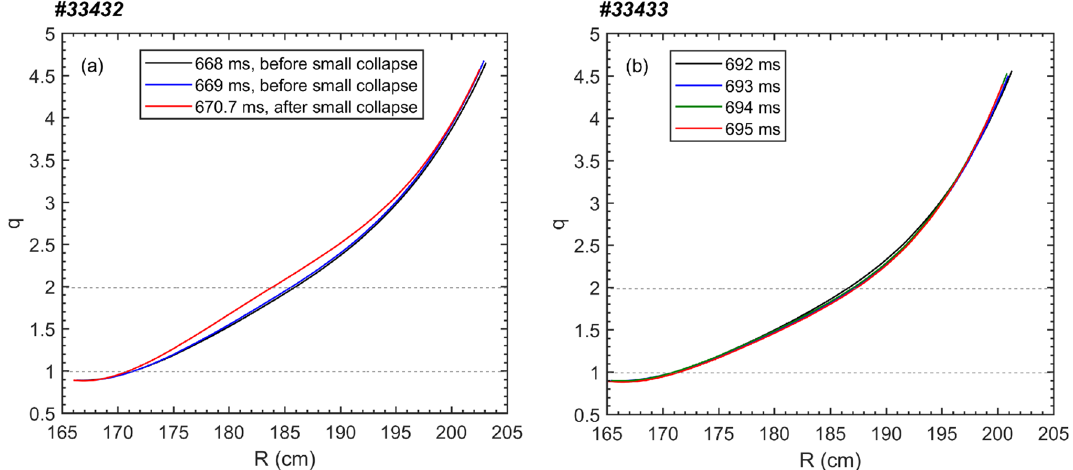
Figure 3. Radial profiles of q values at several times before the TQ for ( a ) #33432 and ( b )